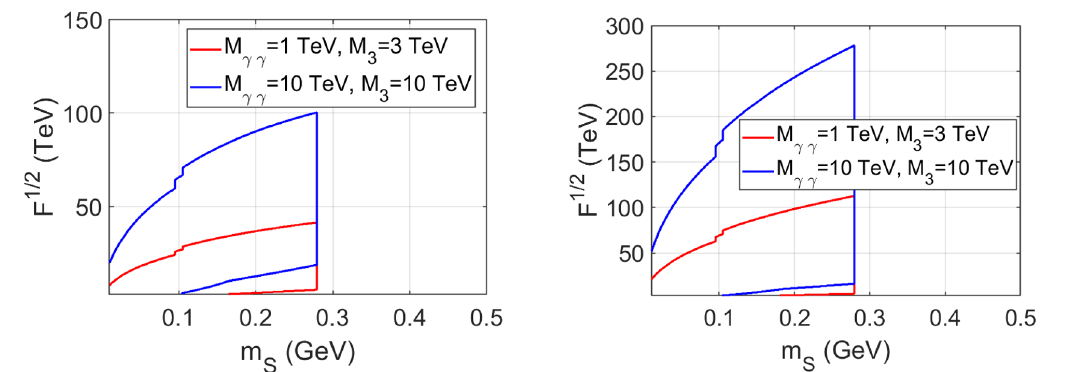
Figure 9 . FASER-I (left plot) and FASER-II (right plot) sensitivity to models with light sgoldstino produced in gluon fusion and decaying into a couple of photons. In the regions where √ we set M γγ = F and the same for M 3